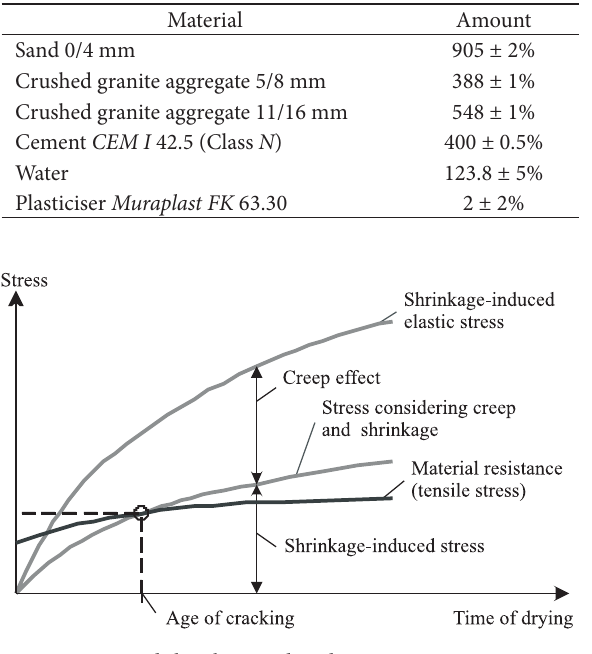
Fig. 1. Restrained shrinkage-induced stress